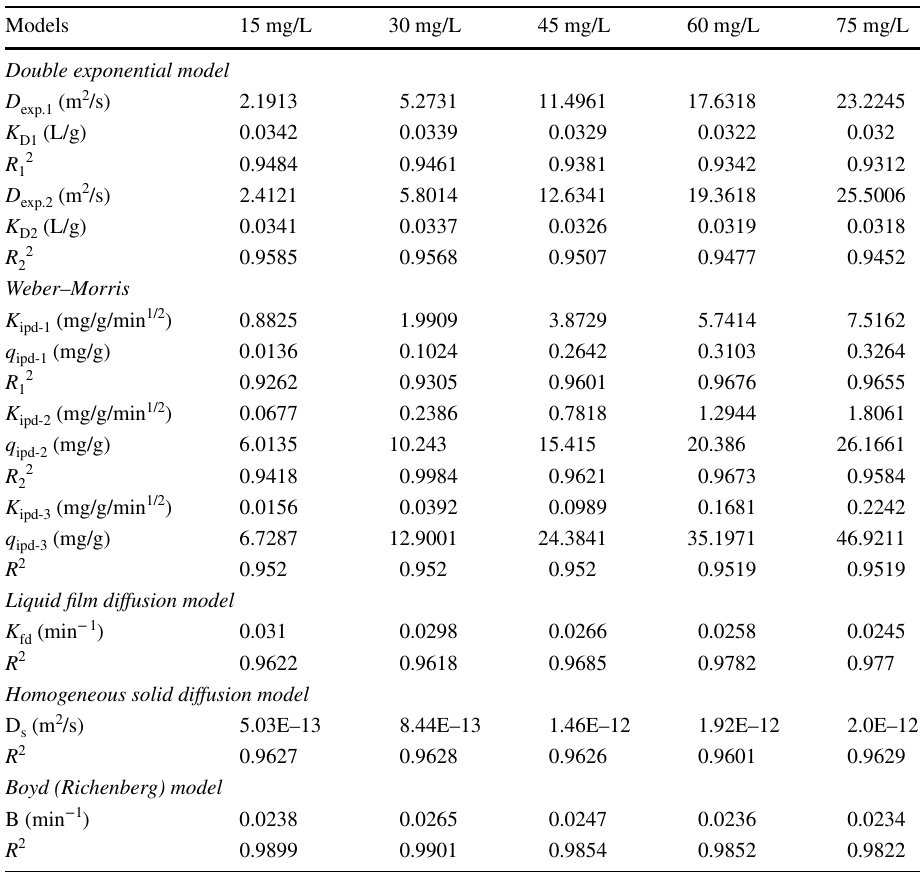
of studied models at varying concentrations of A–N